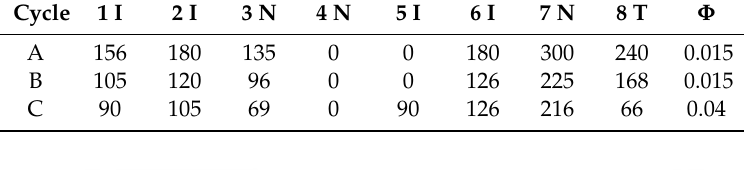
Table 2. Water flux (m 3 / h) in each zone of the laminar cooling for the cycles A, B, and C.